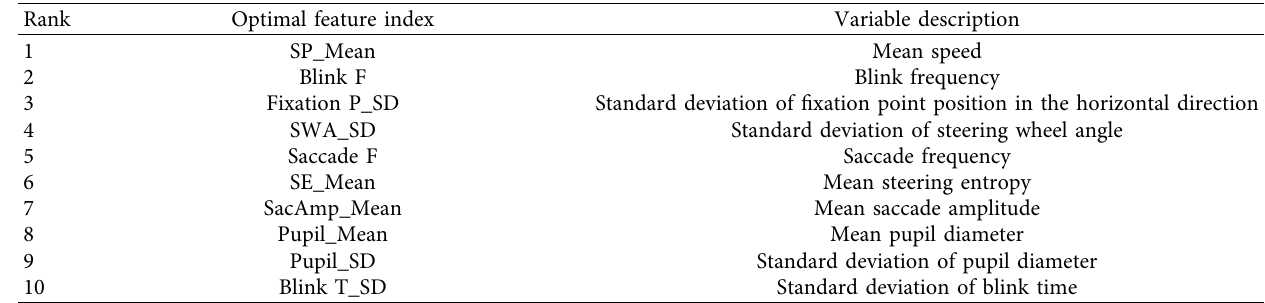
Table 5: Optimal feature index ranking.